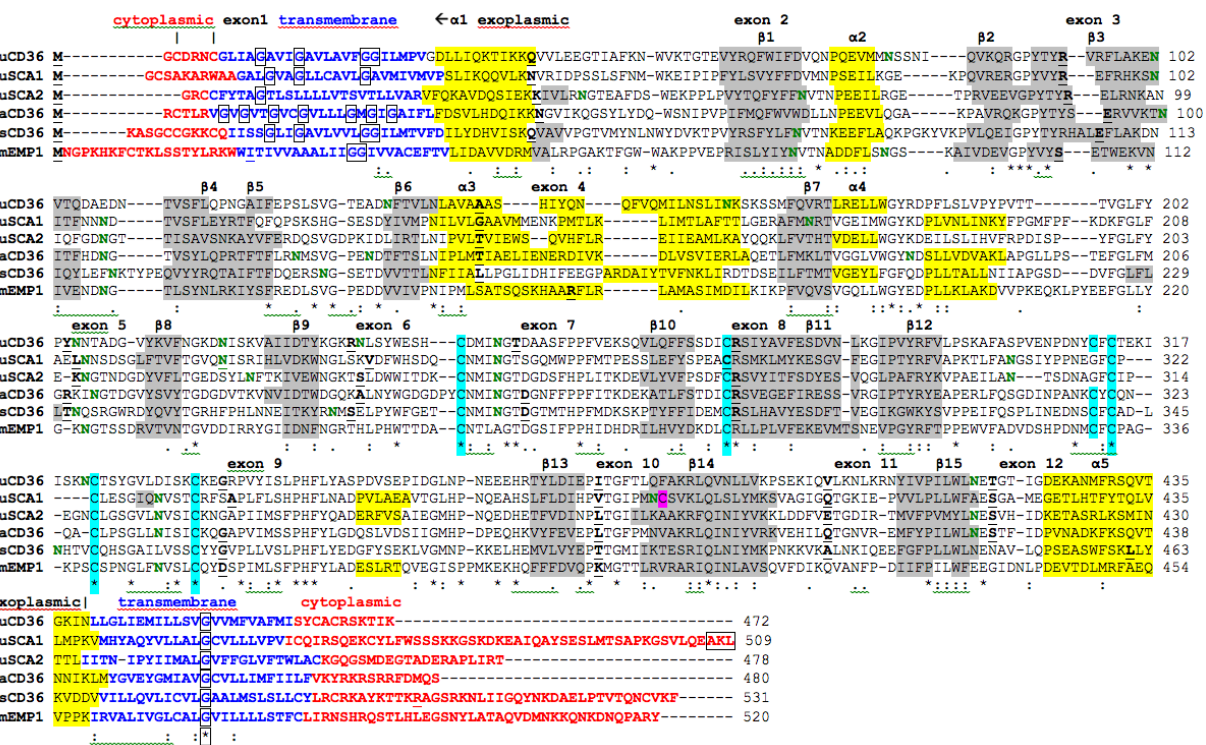
Figure 2. Amino Acid Sequence Alignments for Human CD36, SCARB1, and SCARB2; and Lancelet, Sea Squirt and Fruit Fly CD36-like Sequences. See Table 1 for sources of CD36-like sequences; HuCD36-human CD36; HuSCA1-human SCARB1; HuSCA2- human SCARB2; LaCD36-lancelet CD36; SsCD36- sea squirt CD36; DmEMP1-fruit fly endothelial membrane protein; * shows identical residues for subunits; : similar alternate residues; . dissimilar alternate residues; predicted cytoplasmic residues are shown in red; predicted trans-membrane residues are shown in blue; N -glycosylated and potential N -glycosylated Asn sites are shown in green ; free-SH Cys involved in lipid transfer for human SCARB1 is shown in pink; predicted disulfide bond Cys residues are shown in blue; predicted α-helices for CD36-like sequences are in shaded yellow and numbered in sequence from the start of the predicted exoplasmic domain; predicted β-sheets are in shaded grey and also numbered in sequence; bold underlined font shows residues corresponding to known or predicted exon start sites; exon numbers are shown; G residues refer to conserved glycines in the N - and C -terminal oligomerisation domains of the trans-membrane sequence [49]; C -terminal SCARB1 AKL residues refer to PDZ-binding domain sequences